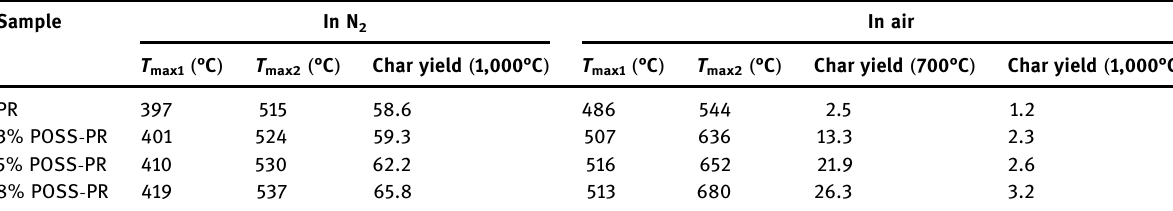
Table 1: Main thermal stability data of POSS - PR Sample